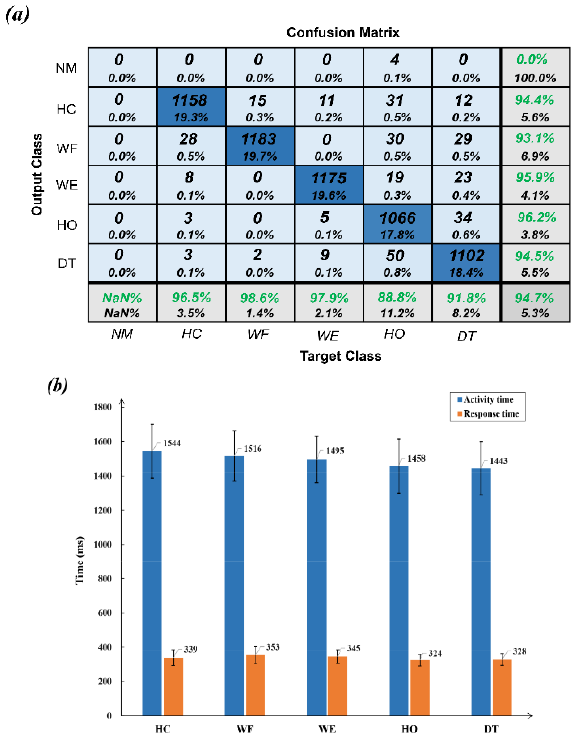
Figure 6. ( a ) Confusion matrix for the proposed hand gesture prediction model with electrode shift correction. ( b ) Comparison of averaged prediction response and activity time on each target hand gesture. Table 2. The classification accuracy for all gestures with di ff erent experimental